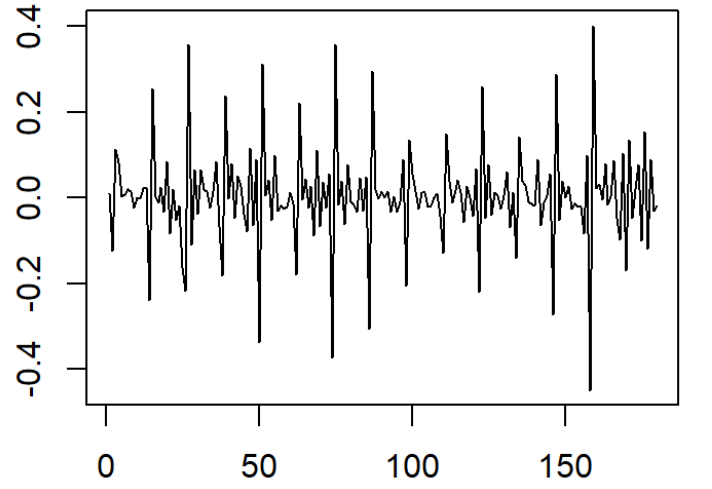
Figure 3. The monthly differentiated log container throughput of Shanghai Port.